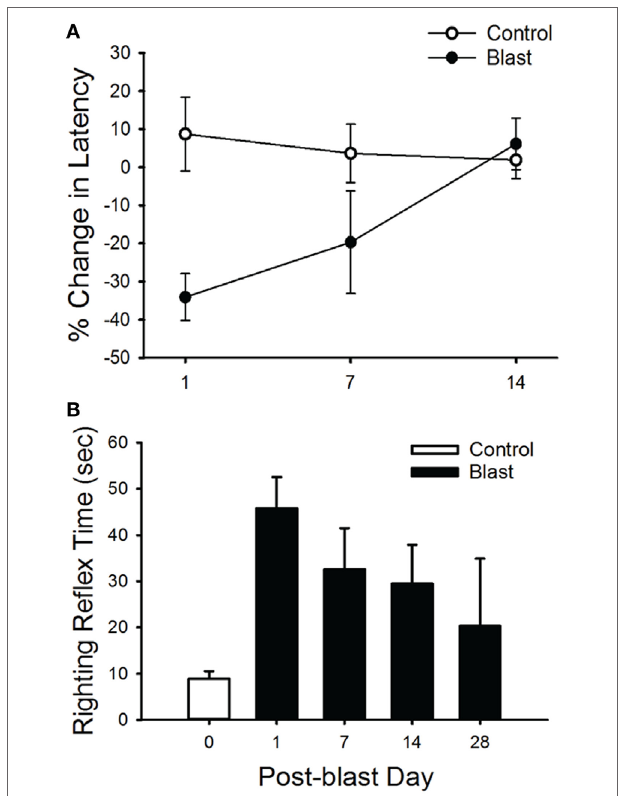
FigUre 2 | Rotarod and righting reflex responses. (a) Animals exposed to a single blast wave (63 kPa) had a significant performance decrease in their mean latency to fall in the rotarod task at 1 and 7 days post-blast exposure ( p < 0.05). However, there was no significant difference between groups at 14 days post-blast exposure. (B) Mean righting reflex responses (time) to control (0 day, white) and post-blast exposed (black) animals, at 1, 7, 14, and 28 days post-exposure. Error bars =